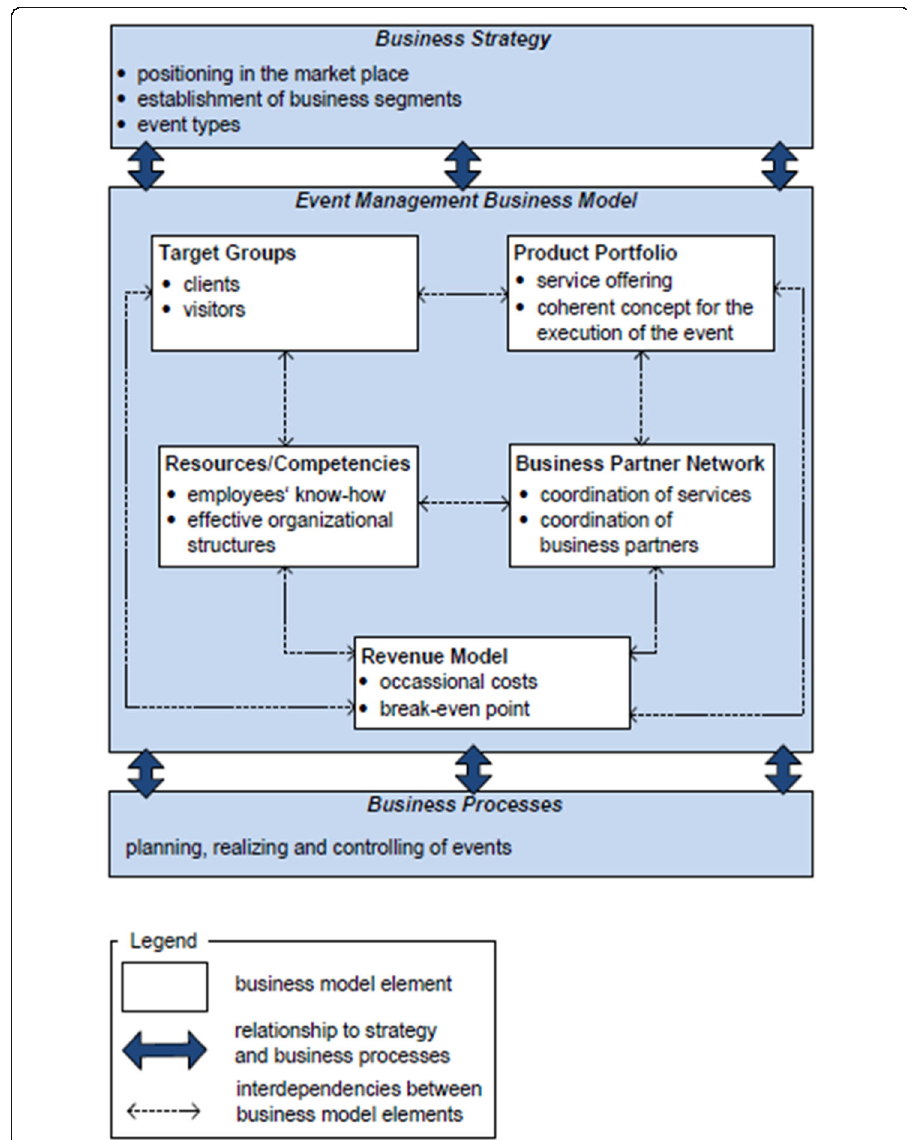
Fig. 8 Framework of AI business model (Samsung White Paper,